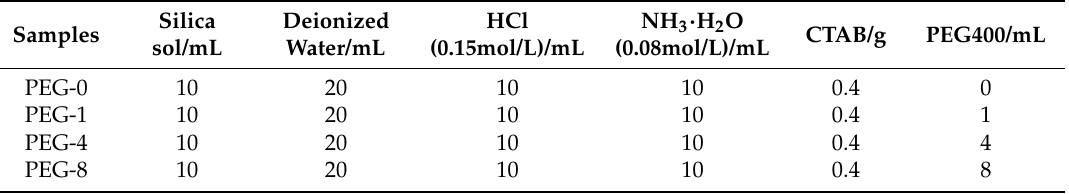
Table 1. Experimental parameters for the synthesis of the silica